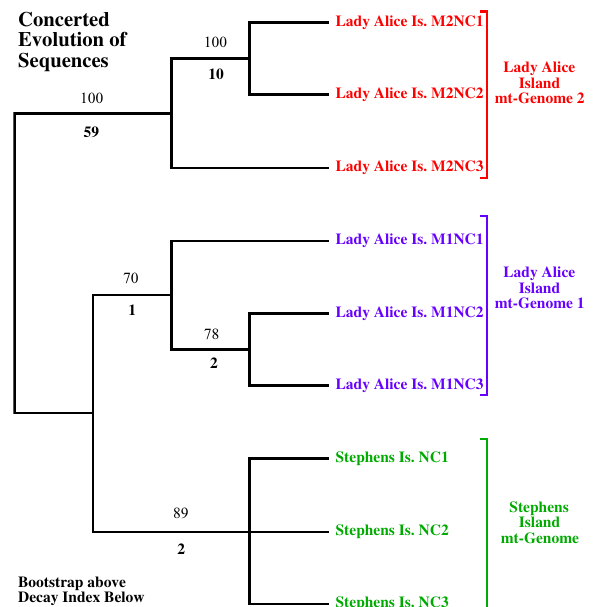
Fig. 5 Phylogenetic tree depicting relationships among non-coding blocks (NC1 – 3) using Lady Alice Island M1 and M2 with Stephans Island sample 4. Strict consensus of two equally parsimonious trees with lengths of 107 steps from analysis of 737 aligned sites of which 80 are parsimony informative. Duplicated regions within an mt-genome cluster, as opposed to all NC1 sequences grouping, all NC2 sequences grouping, and all NC3 sequences grouping; a result consistent with concerted evolution of sequences in which identical or near identical sequences in repeated regions are propagated. Bootstraps are presented above and decay indices are depicted